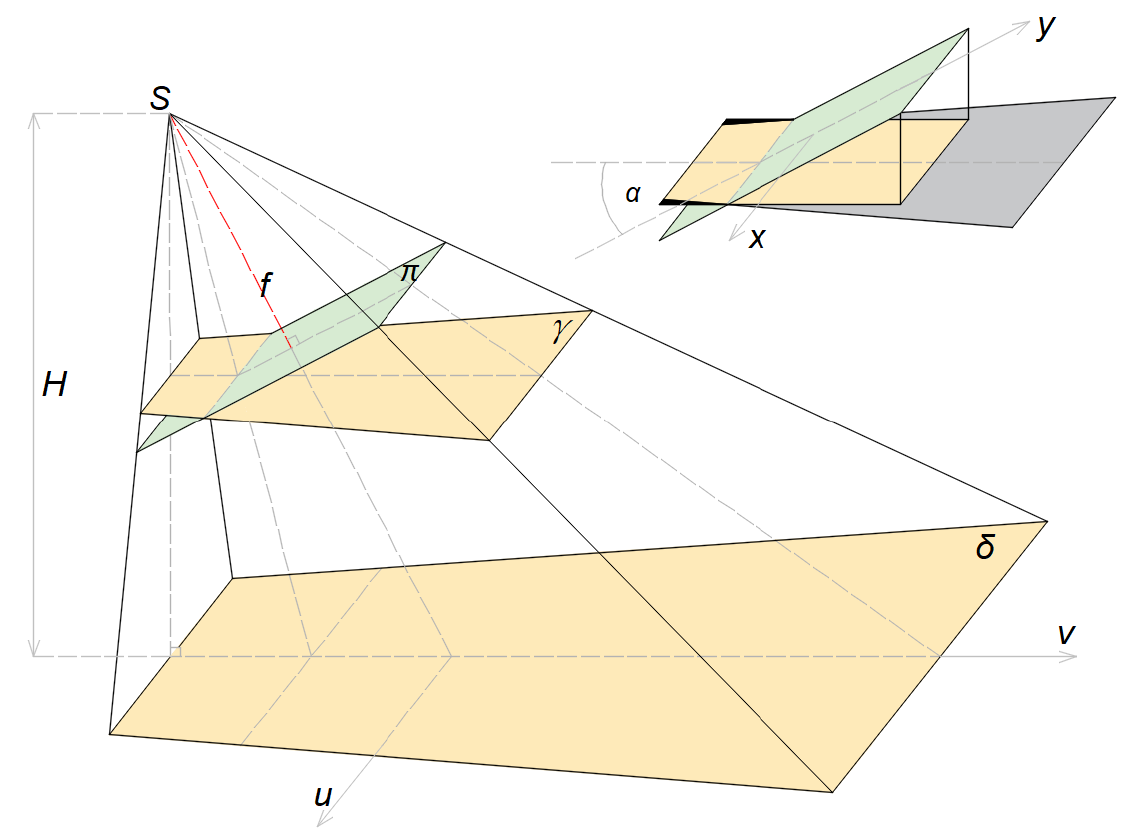
Figure 4. Geometric orthorectification of the image taken from the inclined position: 𝜋 is the image inclined on angle 𝛼 to the scene plane 𝛿 , while 𝛾 is the plane with the orthorectified image.